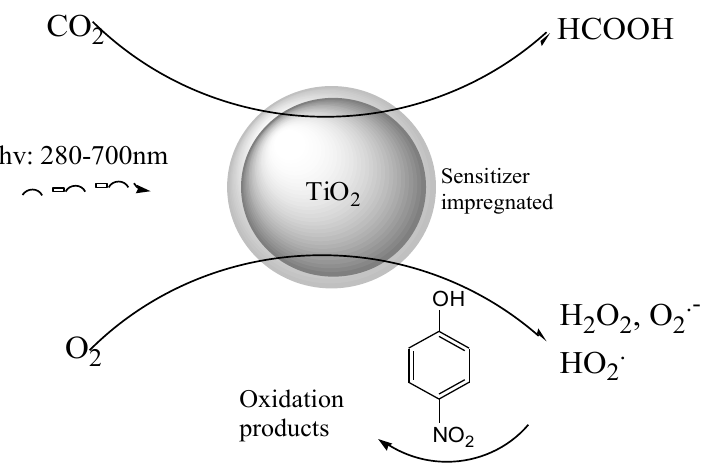
Figure 1. Double activity of CuPc-TiO 2